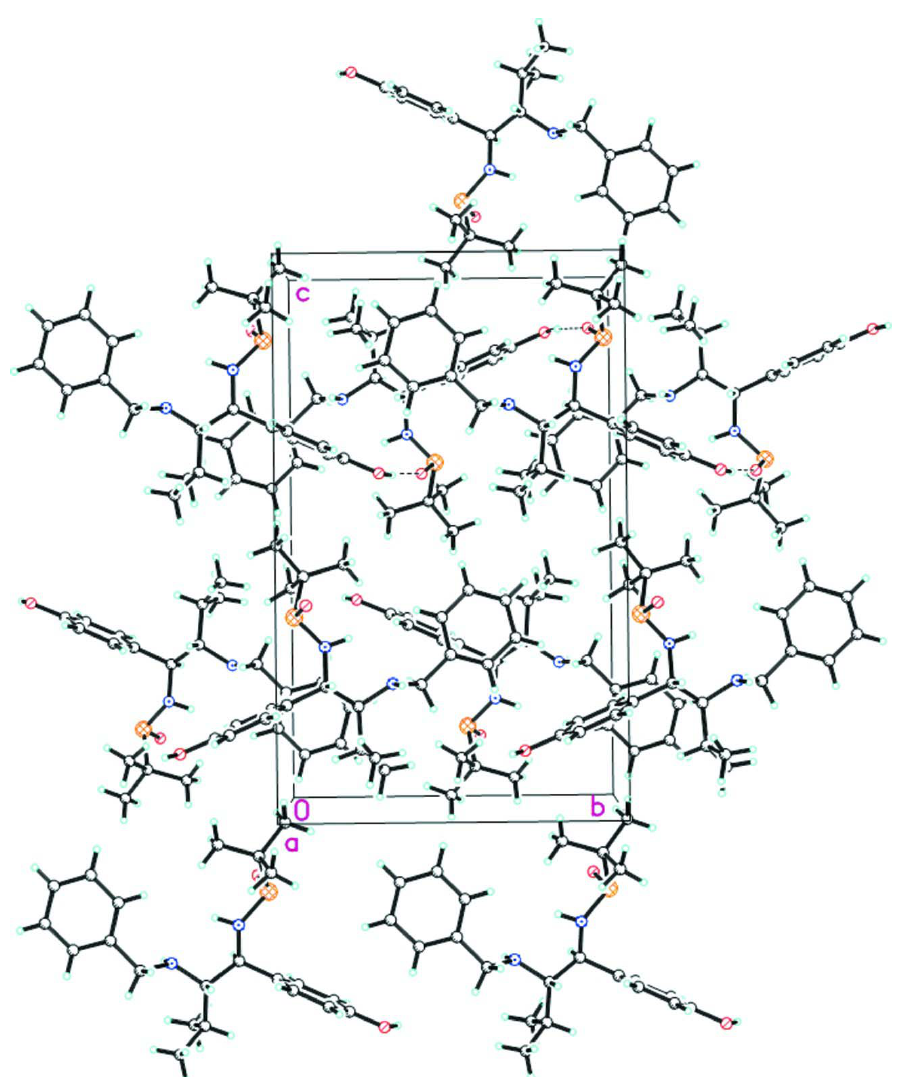
Molecular packing plot, viewed along a axis. Hydrogen bond interactions are shown as dashed lines. ( S )- N -[(1 S ,2 S )-2-Benzylamino-1-(4-hydroxyphenyl)-